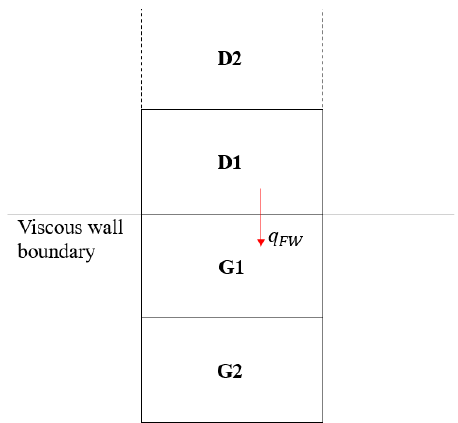
Figure 5. Fluid domain discretization at block boundaries: D1 as the inner domain layer, G1-G2 as the ghost layers.